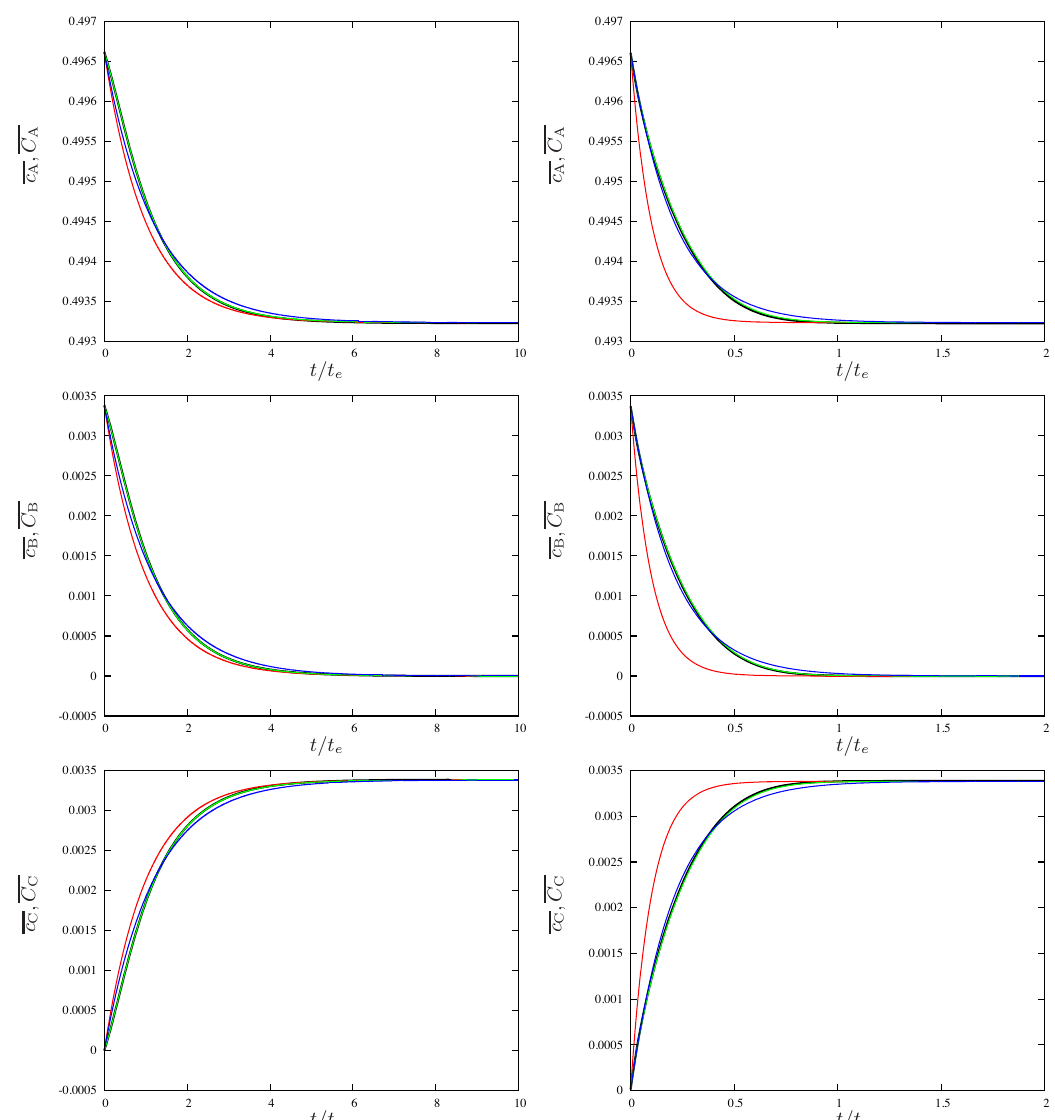
Figure 4. Evolution of computed c k and model grid-averaged C k species concentrations for run I1 (left panel) and I2 (right panel).